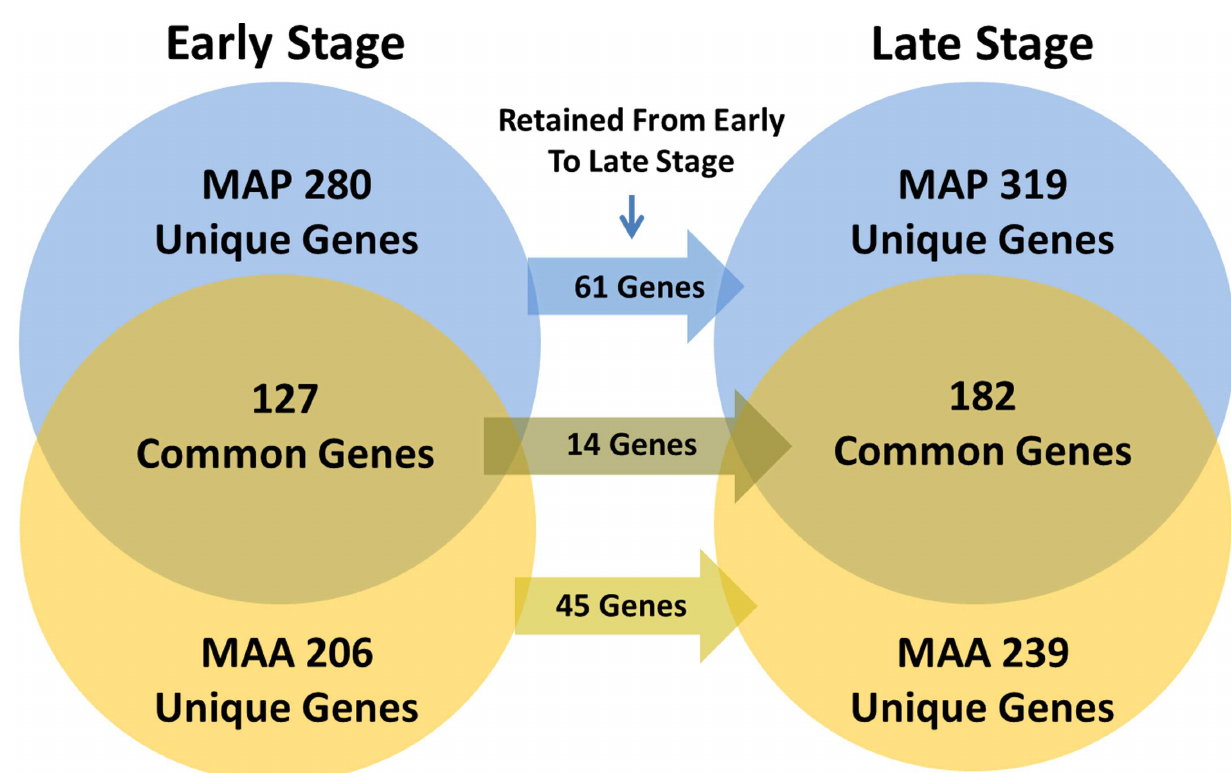
Fig 7. Venn diagramcomparison of the numberof uniqueand commonmechanisticgenesfound for the MAP and MAA conditions. Only the mechanistic genes fromthe pathways and GO termslisted in Table 3 were used in creatingthis diagram.